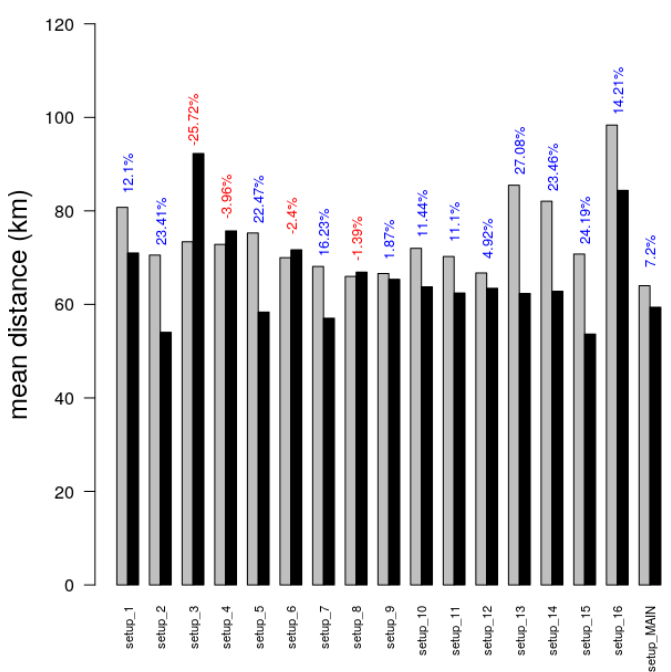
Figure 7. Average track error (km) from 7 November at 06:00 UTC to 8 November at 12:00 UTC (hourly) between the “best” track of TLC, as derived from ERA5 and satellite imagery, and the model experiments for the low (grey bars) and high (black bars) resolution domain. The difference (%) between the two domains is depicted above the bars.